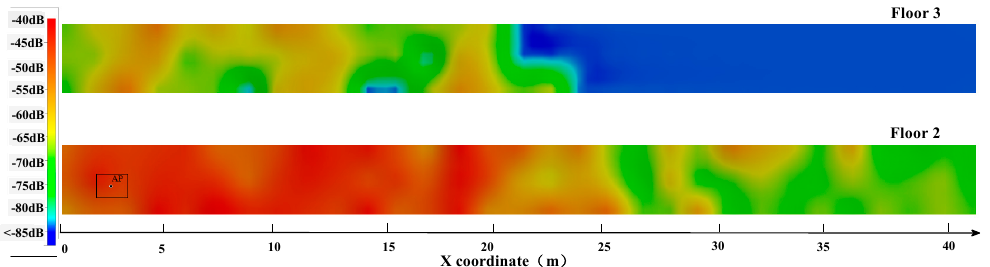
Figure 5. The RSSI distribution of the test AP on two different floors in which the red part indicates that the signal intensity is high.